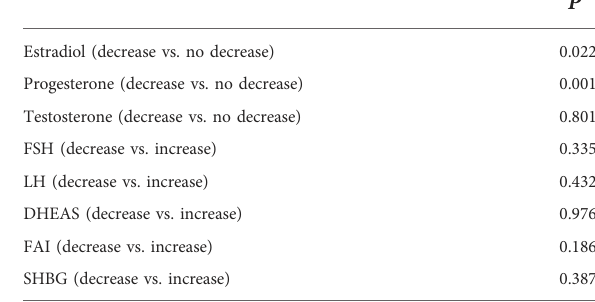
TABLE 6 Kaplan – meier analysis of RFS by reproductive hormones